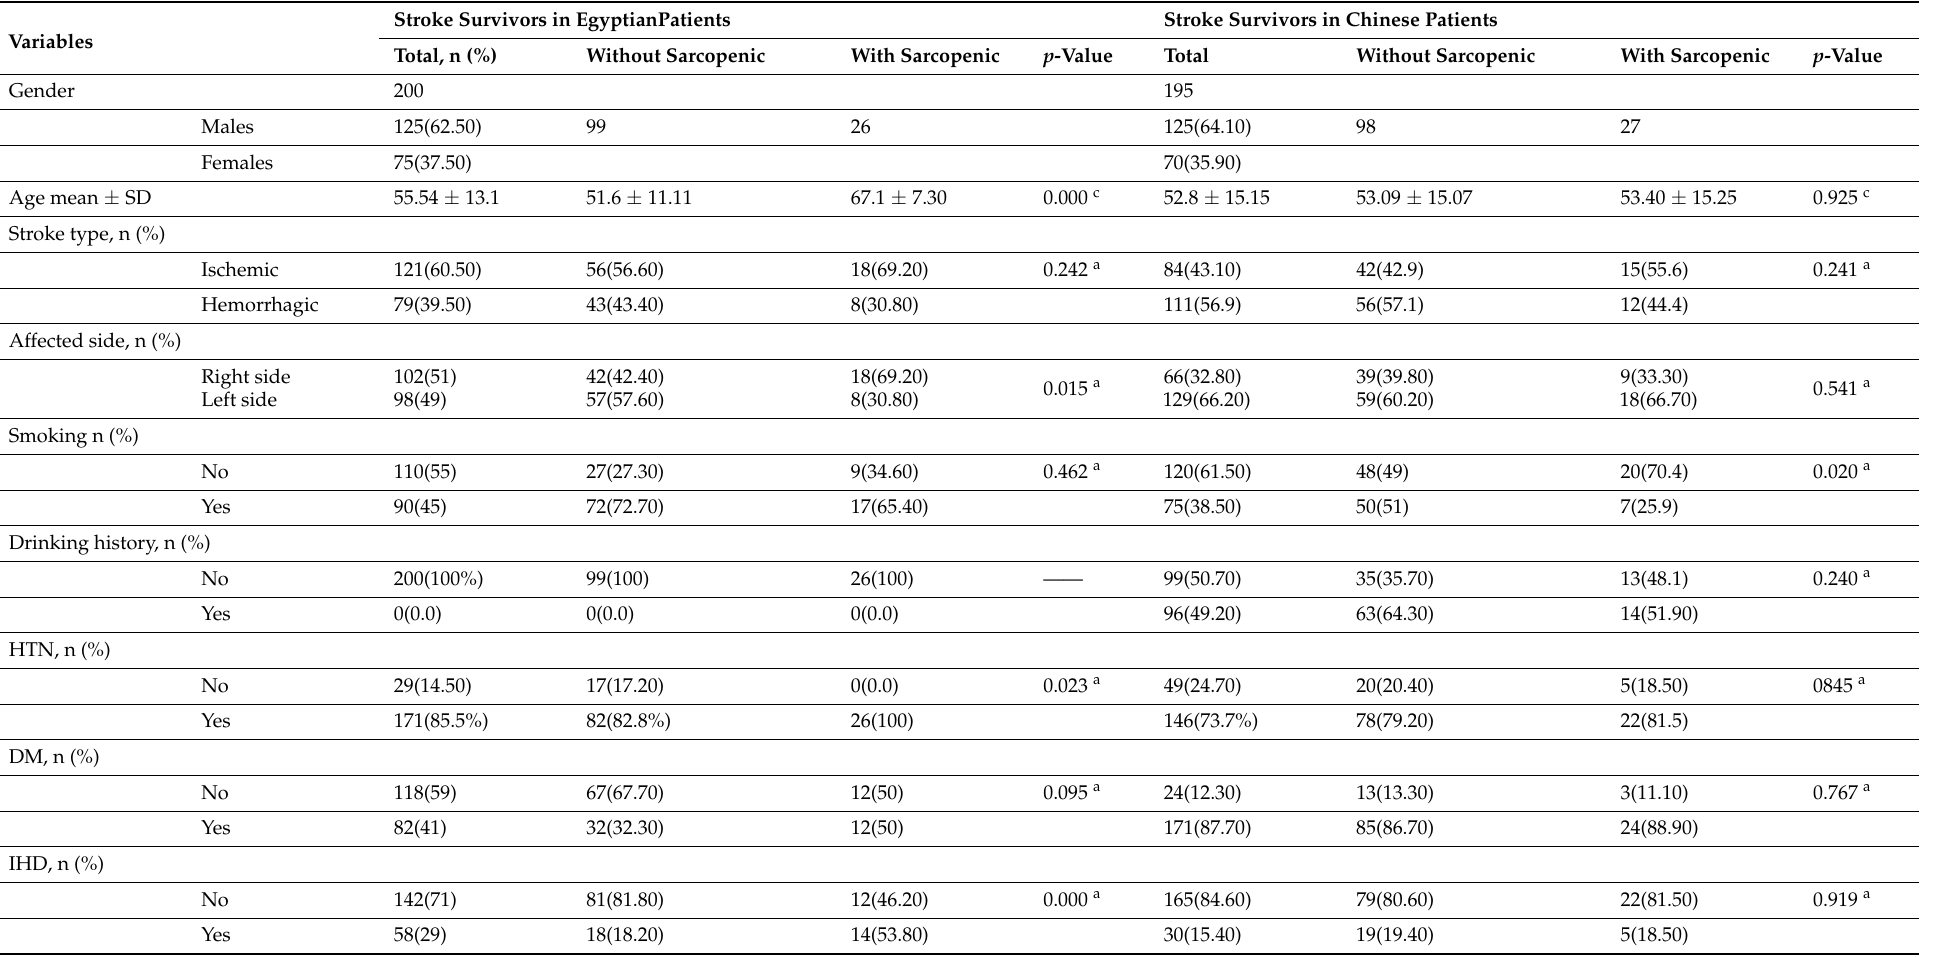
Table 1. The basic characteristic of stroke survivors between the male Egyptian versus Chinese patients with or without